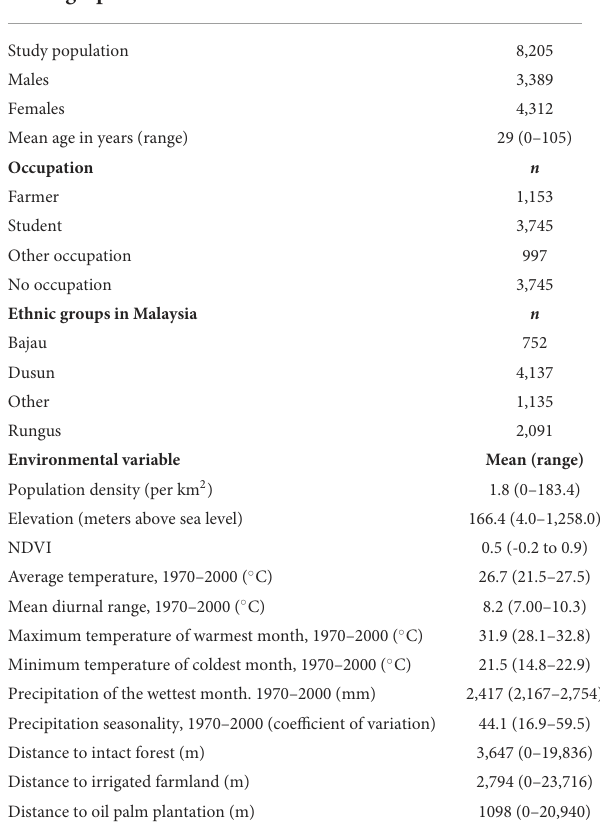
30-bead count per analyte were recorded. The P. vivax control curve was included on each plate to standardize data between plates